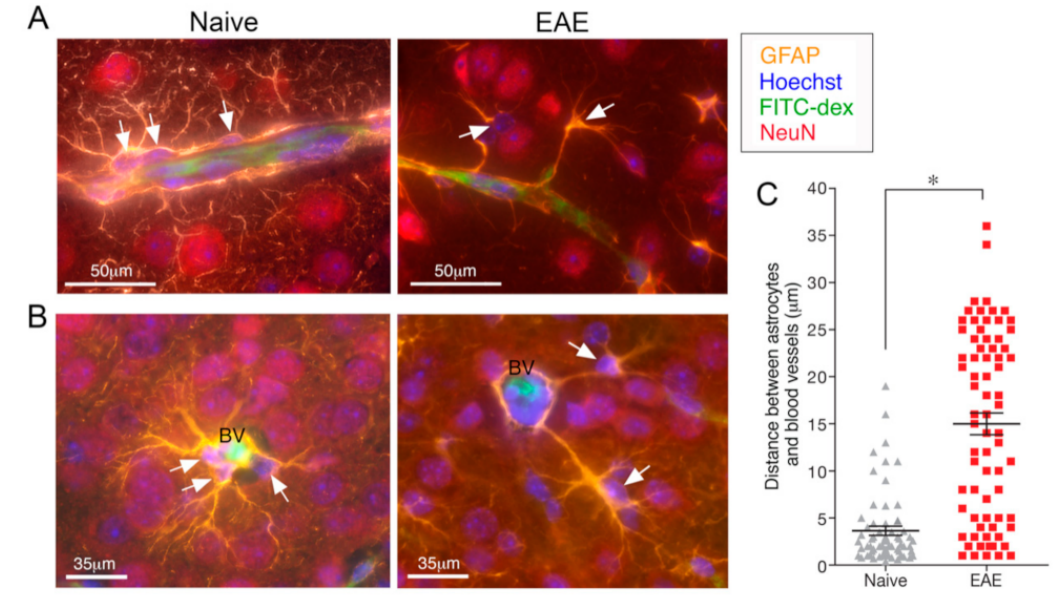
Figure 3. Reactive astrocytes detach from the perivascular vicinity and lose the endfeet coverage around the blood vessels (BV). Immunohistochemical depiction of the neurovascular unit in the motor and somatosensory cortex (layer IV). The lumen of the microvessels is visualized by its FITC-dextran content, astrocytes by GFAP expression, neurons by NeuN expression, and overall cell nuclei by Hoechst staining. Representative images from naïve and EAE mice, 21 days after EAE induction. ( A ) Longitudinal sections along blood vessels and ( B ) cross sections of penetrating blood vessels. Arrows indicate location of astroglial cell bodies. ( C ) Quantification of the distances between individual astrocytic cell bodies and their neighboring blood vessels. * p < 0.05. Adapted with permission from ref. [71]. Glia 2018, 66, 1098-1117. Copyright Year 2021, John Wiley and